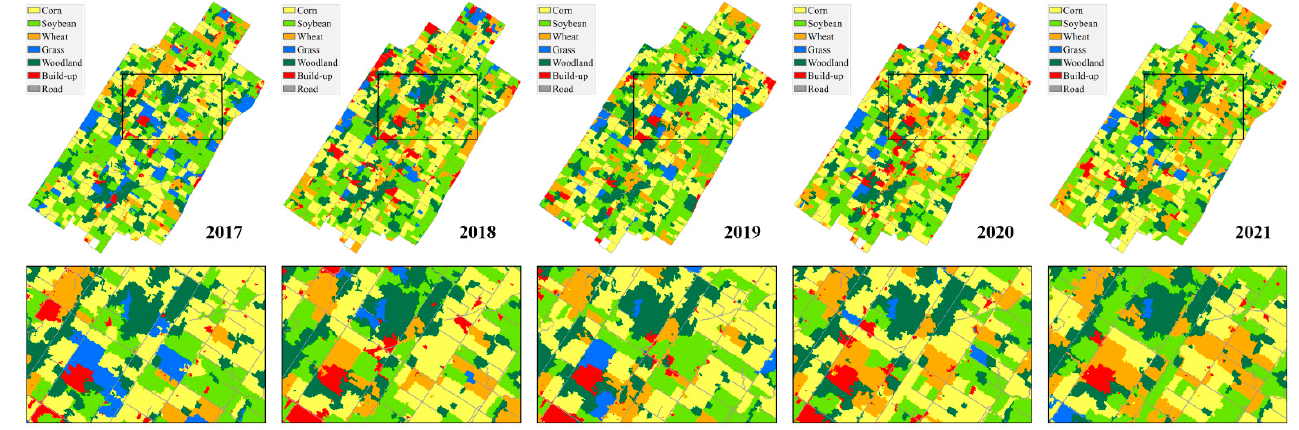
Figure 12. Annual crop mapping results from 2017 to 2021 based on automatic segmentation. Table 5. The quantitative evaluation results of annual crop maps from 2017 to 2021 based on automatic segmentation. Four metrics were selected, including producer’s accuracy (PA), user’s accuracy (UA), overall accuracy (OA), and Kappa.